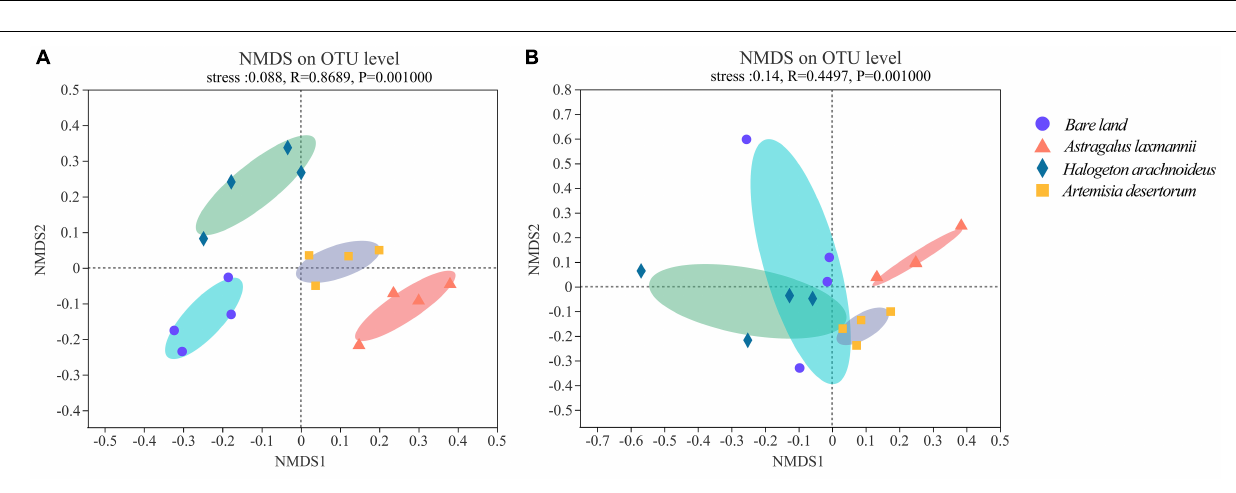
FIGURE 4 | Non-metric multidimensional scaling (NMDS) of (A) bacterial and (B) fungal communities in soils from bare land and re-vegetated areas with different plant species. OTU, operational taxonomic